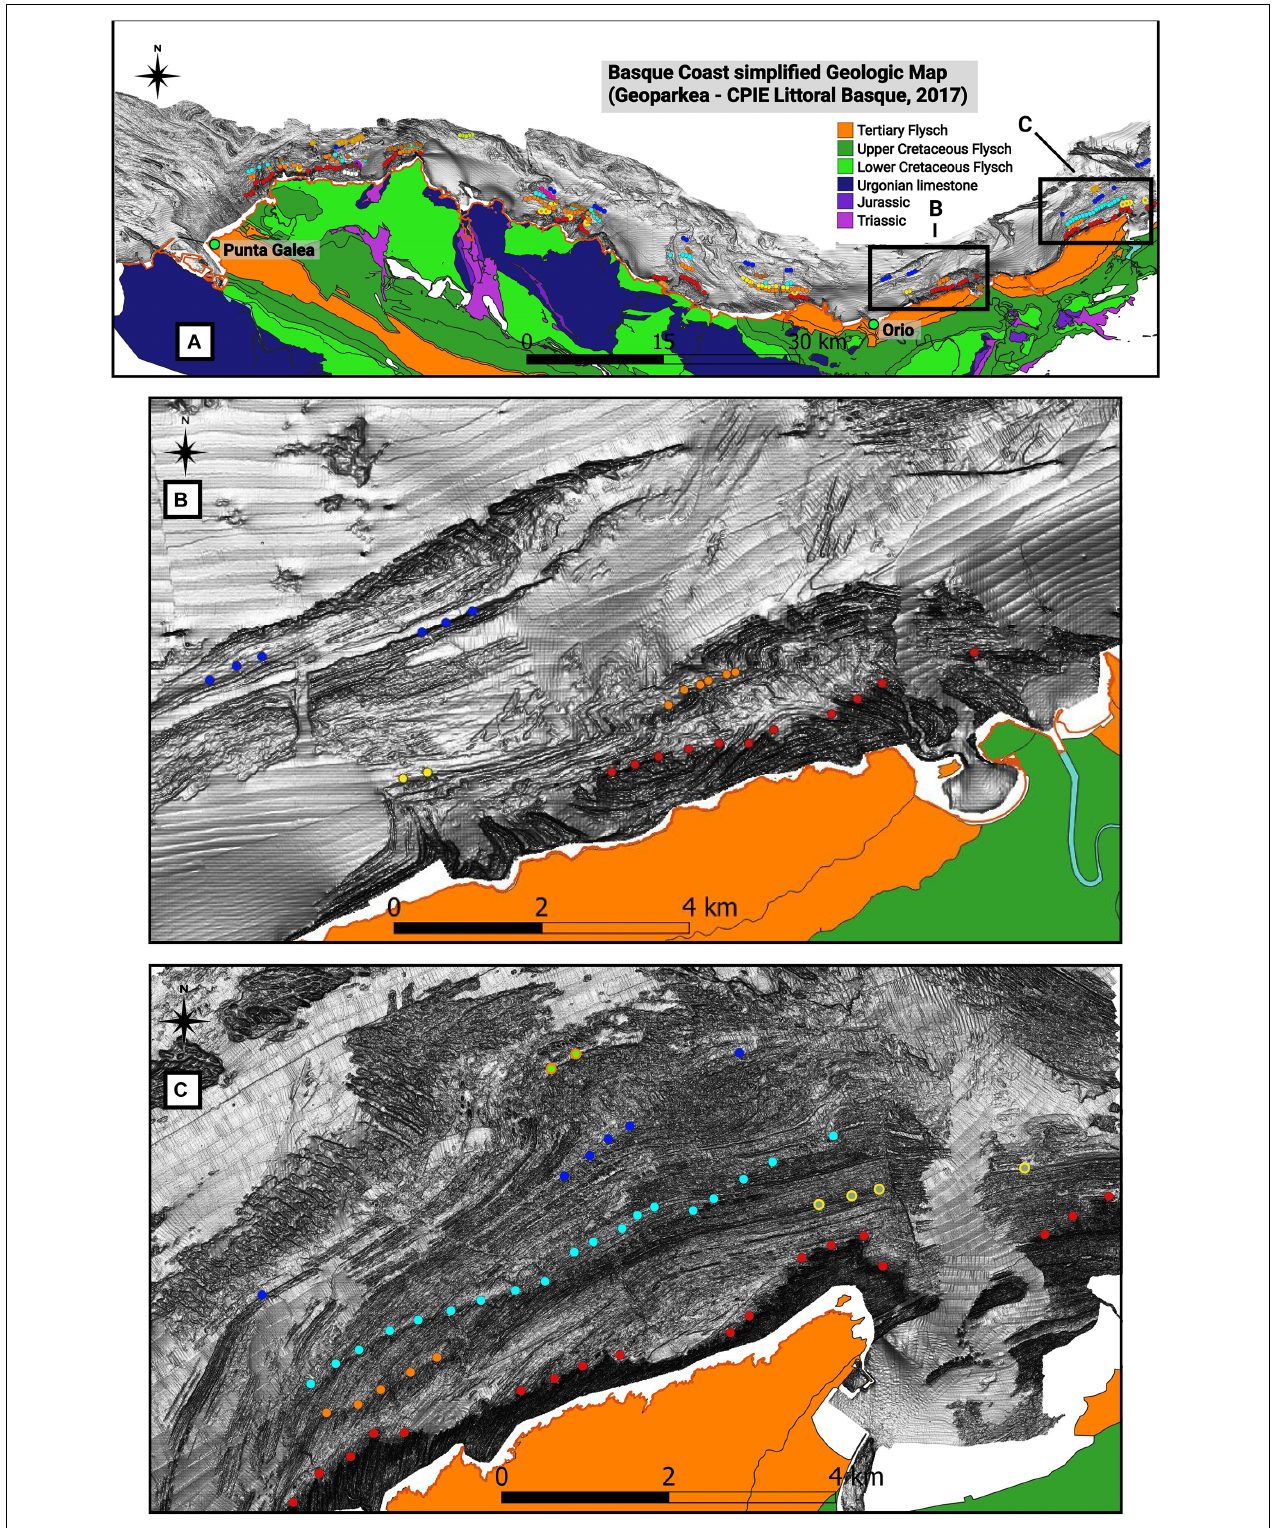
FIGURE 12 | Relationship between submerged marine terraces and bedding. (A) Distribution of the detected shoreline angles in the study area. Boxes highlight the areas detailed in figures (B,C) . (B,C) Oblique or parallel bedding in high wave energy areas, which could explain why some submerged terraces are preserved at this site, and not at other sites experiencing similar hydrodynamics within the same lithology as in Punta Galea ( Figure 11C ).